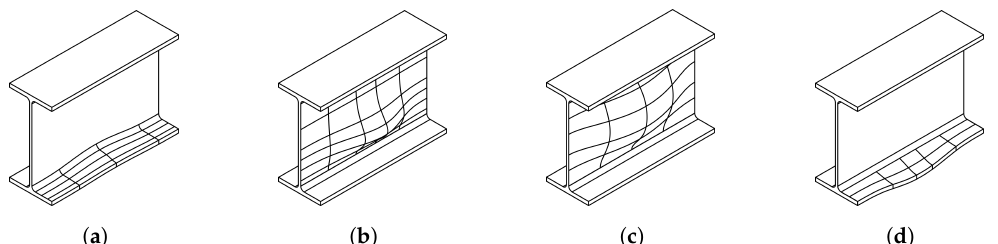
Figure 5. Failure modes: ( a ) plastic failure; ( b ) local buckling; ( c ) buckling of entire web height; ( d ) bending of the flange.